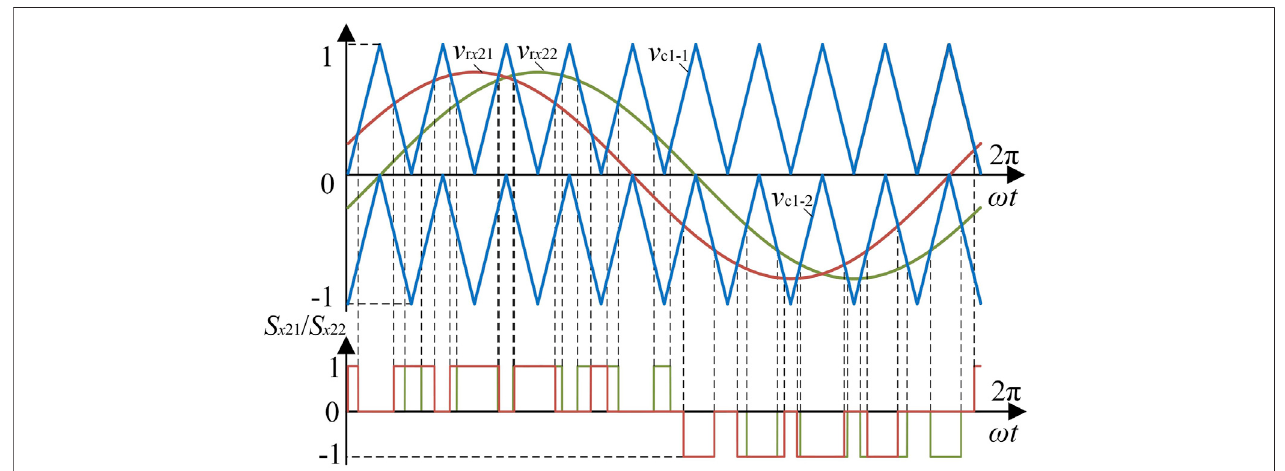
FIGURE 3 | Diagram of the equivalent duty ratio calculation.